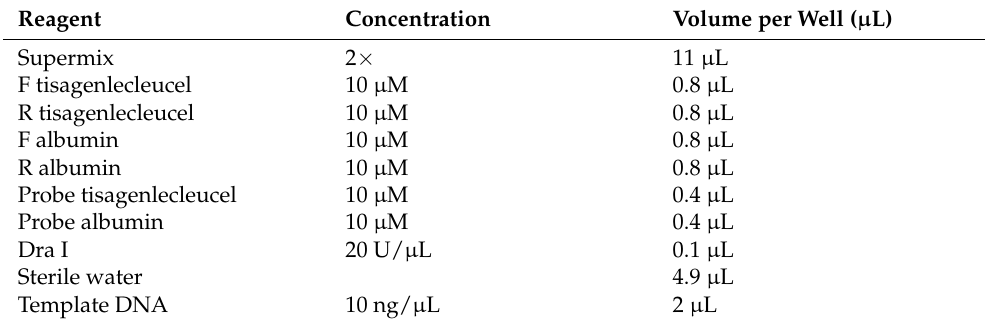
Table 1. Mastermix for